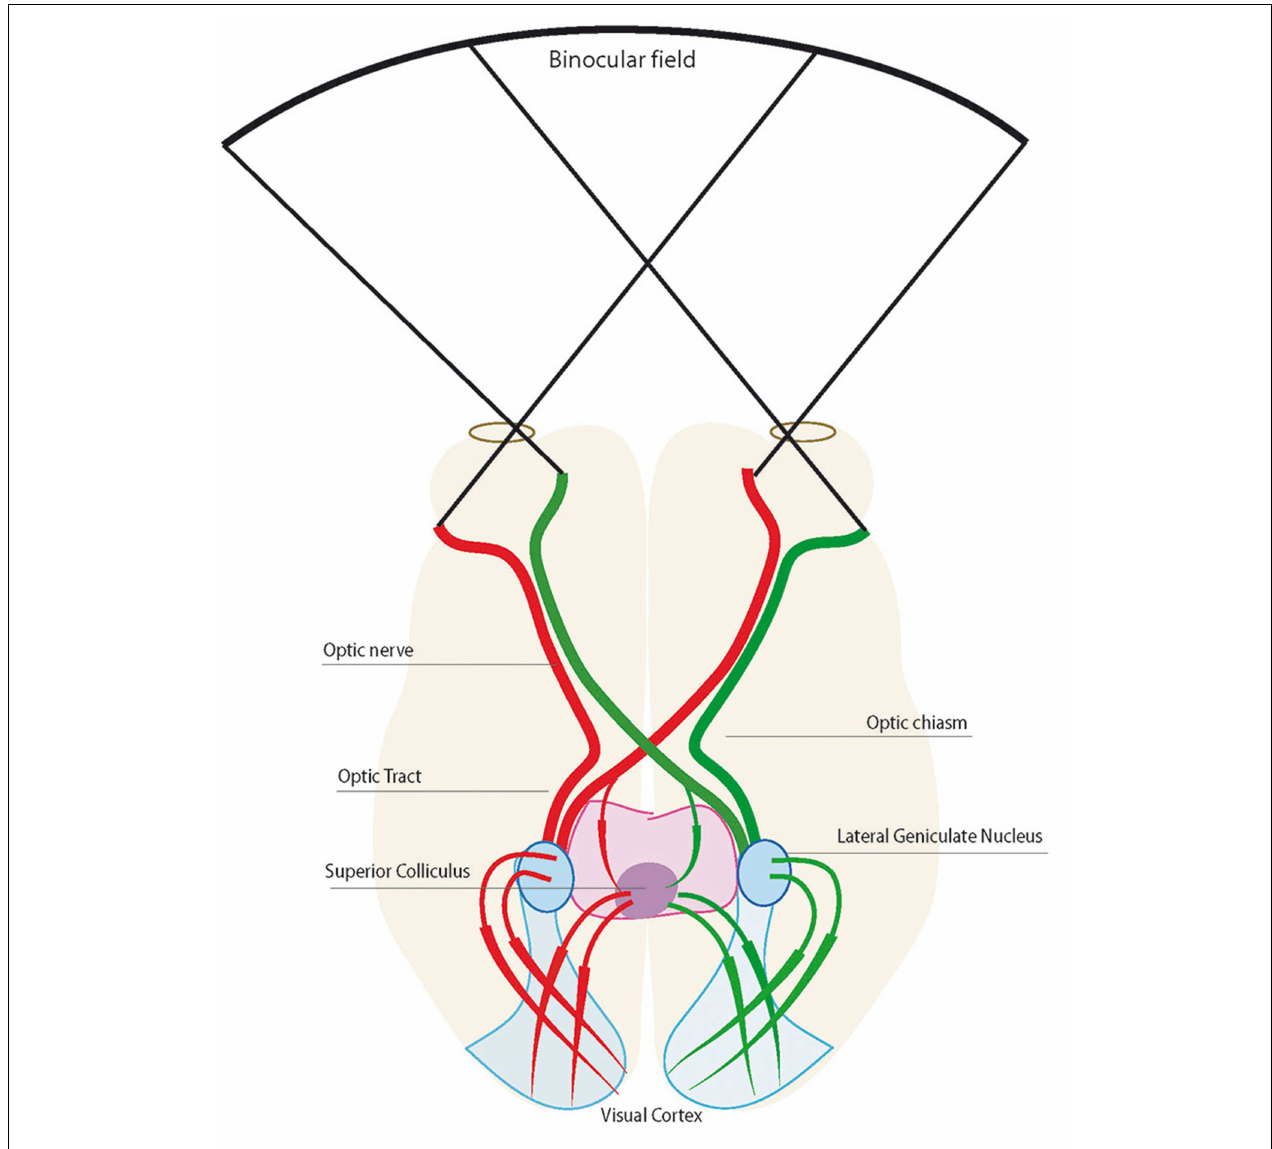
crossed neuron fibers in the optic chiasm, visual information about the right hand will reach the left hemisphere, which also receives tactile and proprioceptive information. The left hemisphere also steers the right hand, hence, all involved neurons are situated in the same hemisphere. Reprinted from Herrera and Mason (2007) with permission from Elsevier and the